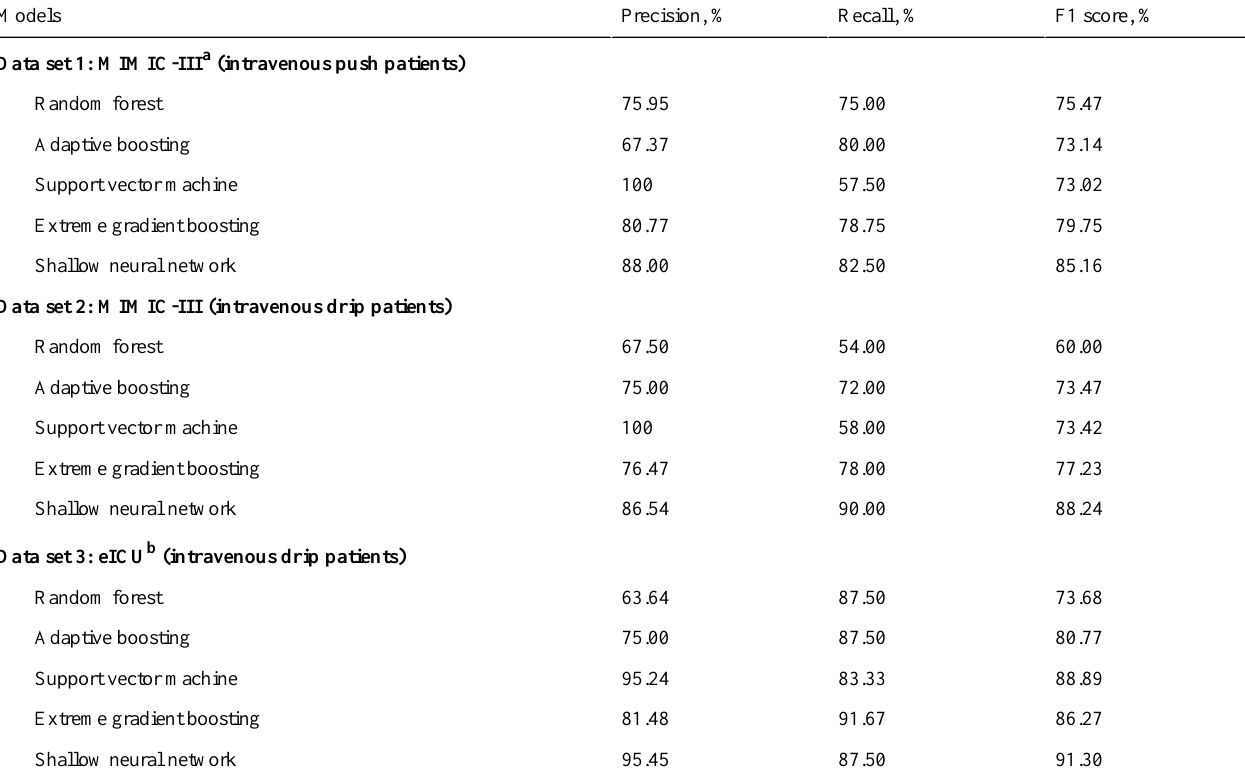
F1 score, %Recall, %Precision, %Models